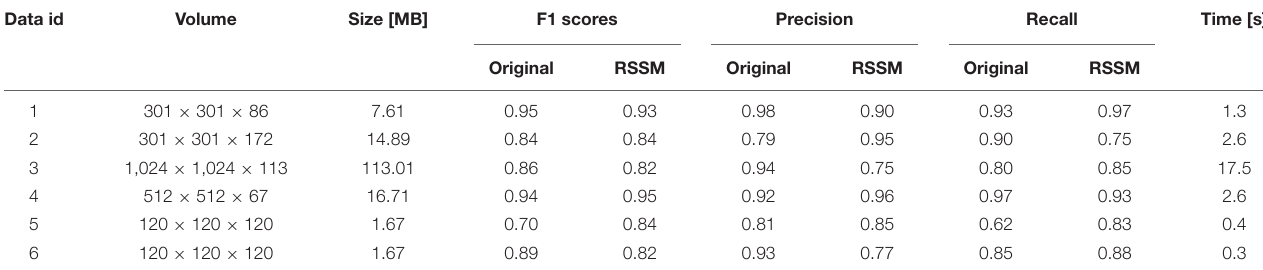
FIGURE 4 | RSSM facilitates robust quantification on the estimated foreground. (A) Neurites images collected using fMOST system and their corresponding tracing results. (B) Neuronal images with a complete single neuron from the public BigNeuron (left) and Diadem (right) dataset and their tracing results. (C) Neuronal images collected using light-sheet microscopy and their corresponding soma localization results. (D–F) Are the estimated foreground images by RSSM and their corresponding quantitative results. The NeuroGPS-Tree software is used for neurite tracing and soma localization. Thre is a key threshold parameter in NeuroGPS-Tree for neurite tracing and soma localization. TABLE 1 | Evaluation of NeuroGPS-Tree on neuronal images for neurite tracing and soma